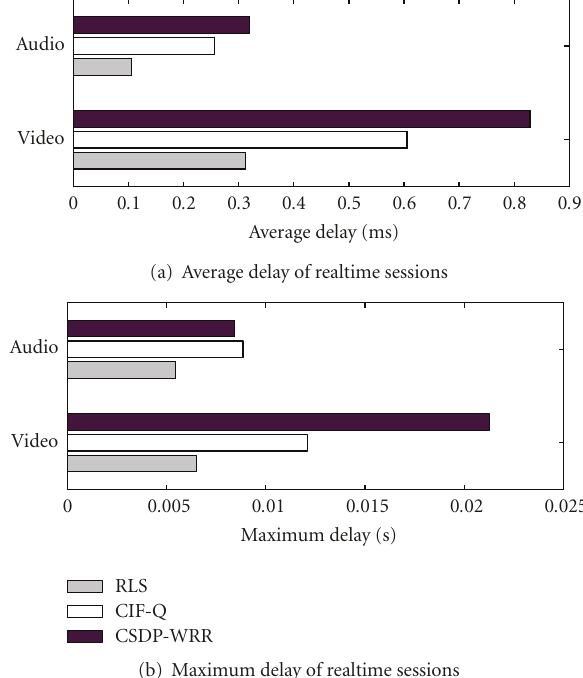
Figure 7: Comparison on delay of realtime